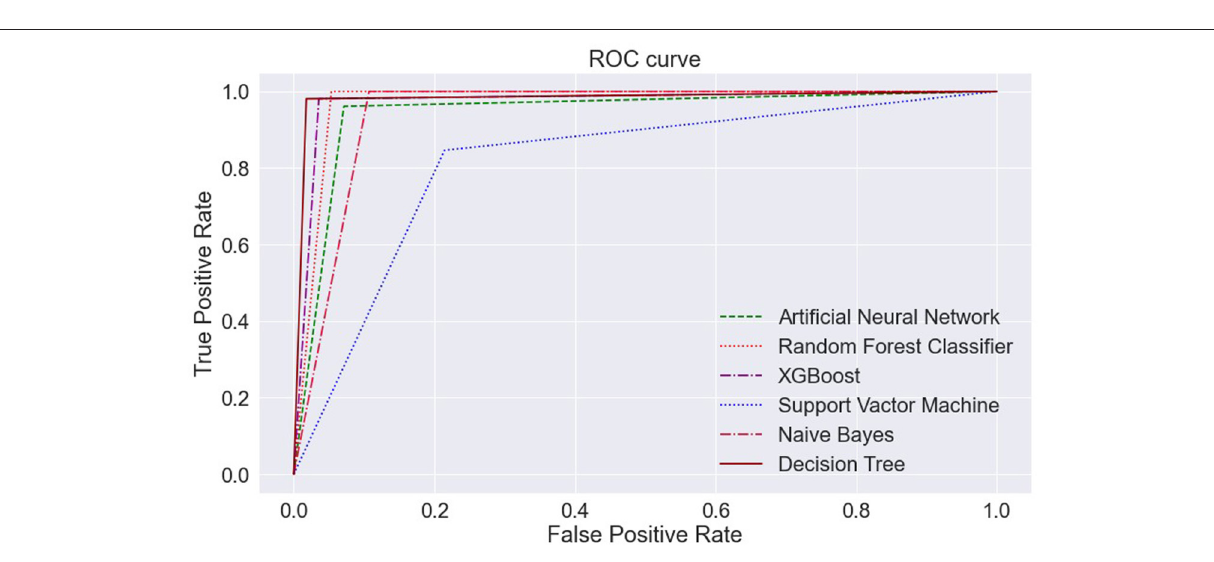
FIGURE 14 | ML models—ROC curve. ML, machine learning; ROC, receiver operating